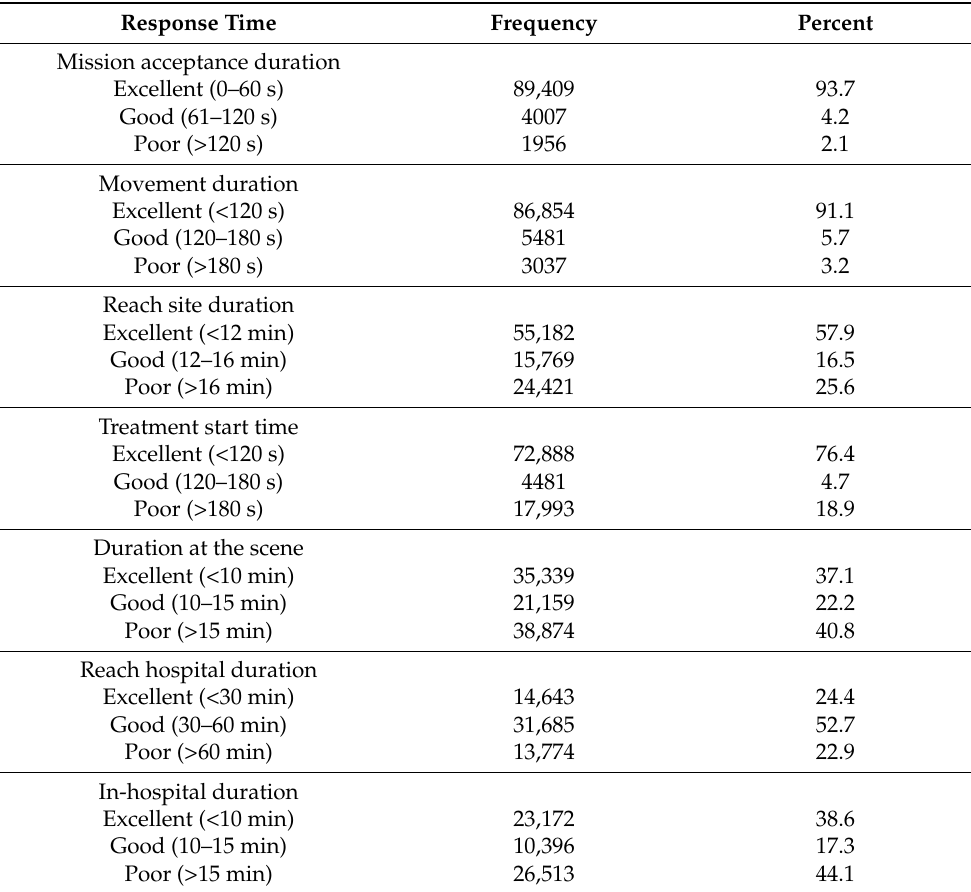
Table 2. SRCA’s response time to road traffic accidents in the